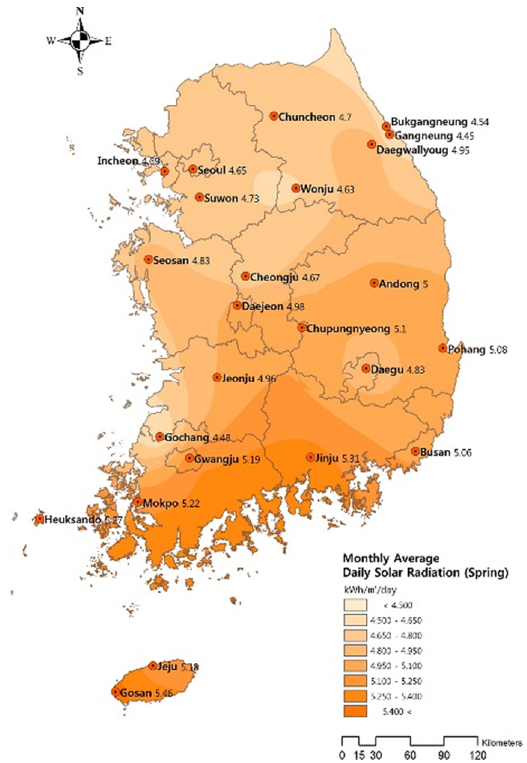
Figure 3. Map of daily average solar radiation availability in South Korea [33].